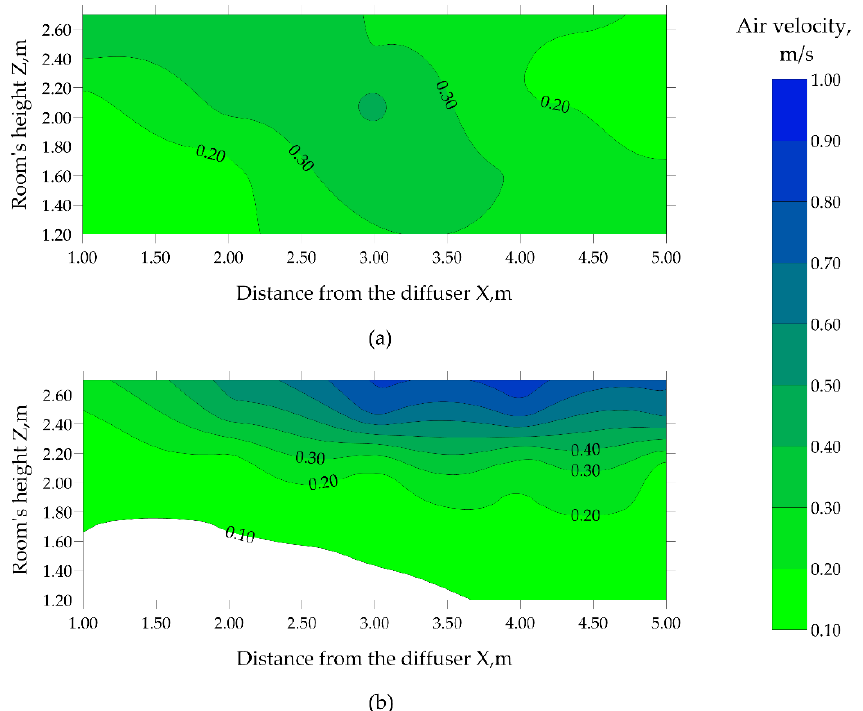
Figure 8. Isolines of air velocity distribution from the supply air for Y = − 0.15 m: ( a ) diffuser Type I; ( b ) diffuser Type II.